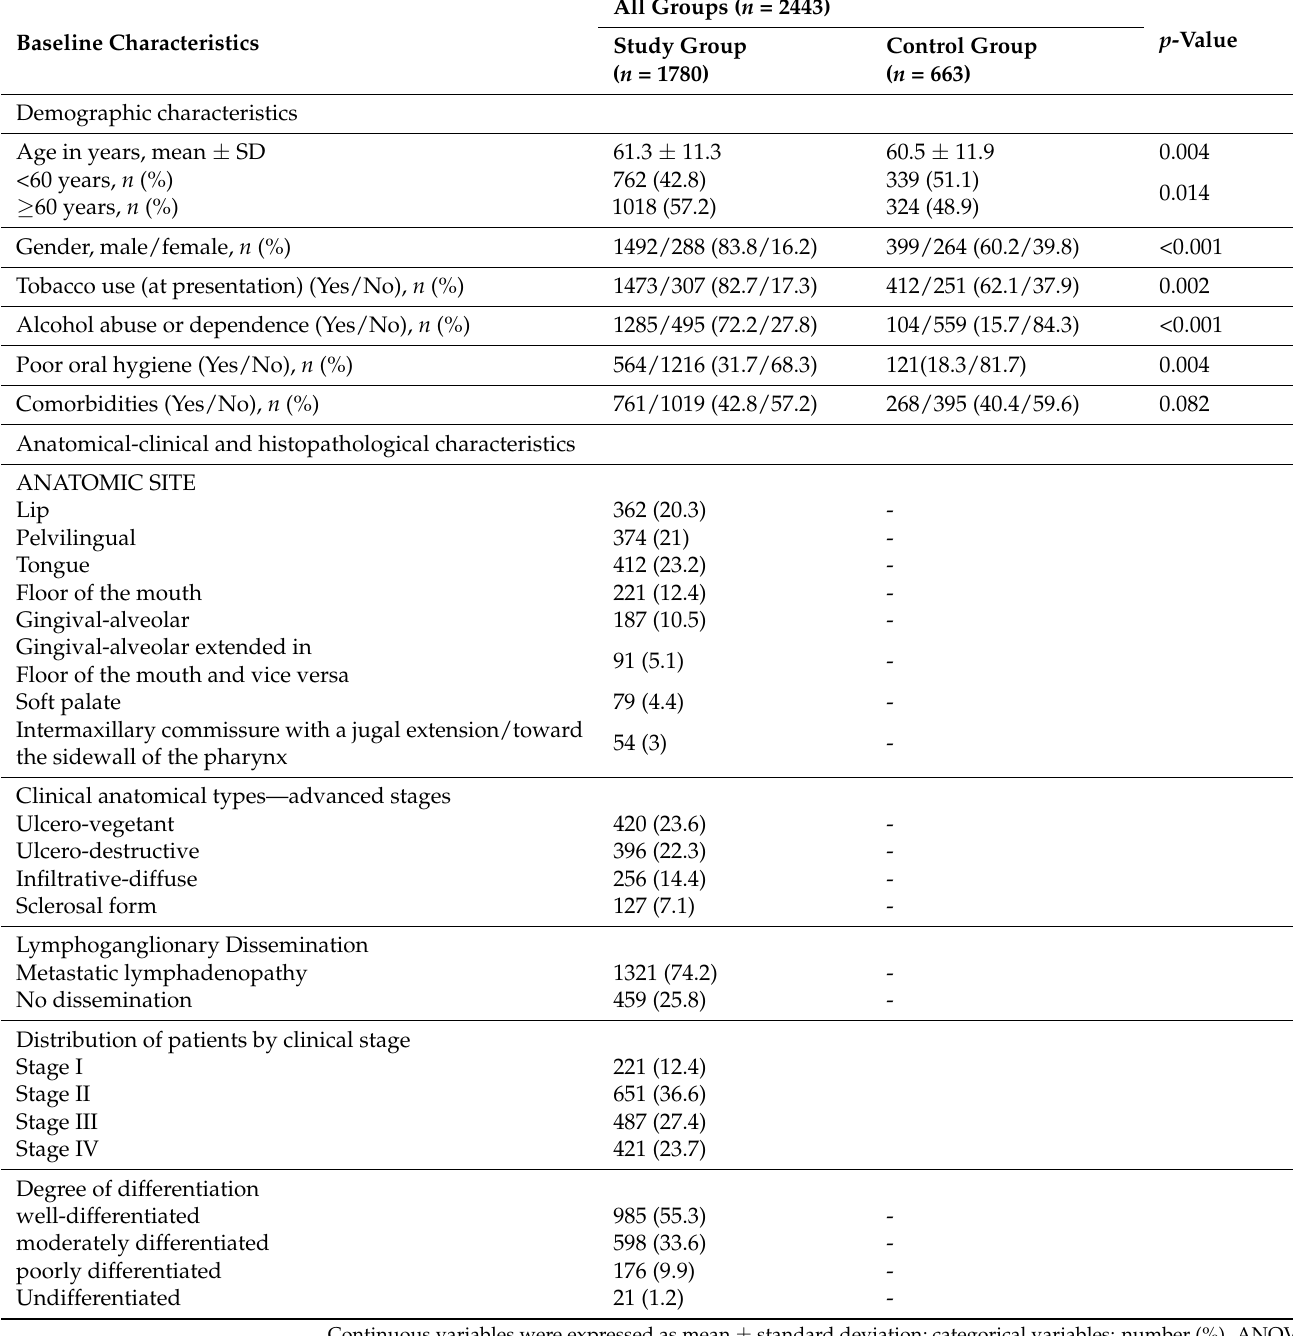
Table 1. Demographic, anatomical-clinical, and histopathological characteristics of the analyzed